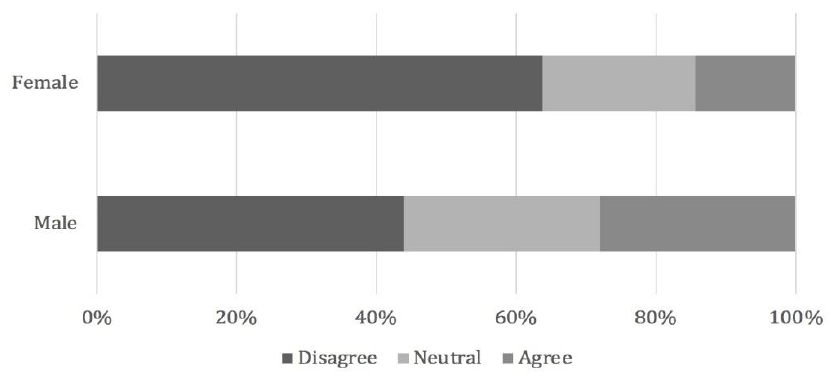
Fig. 5. Sexism in engineering is